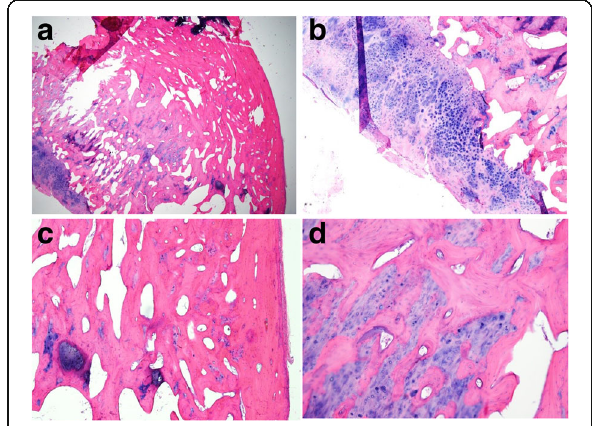
Fig. 8 Histopathologic findings of the tumor mass. a × 10, cartilaginous cap could be identified. b ×20, head of the condyle. c ×40, endochondral ossification progressing beneath the cartilaginous cap. d ×100, hyaline cartilage gradually changed into trabecular